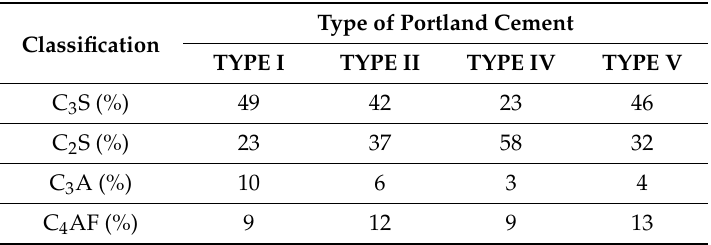
Table 1. Chemical composition of Portland cement [23].